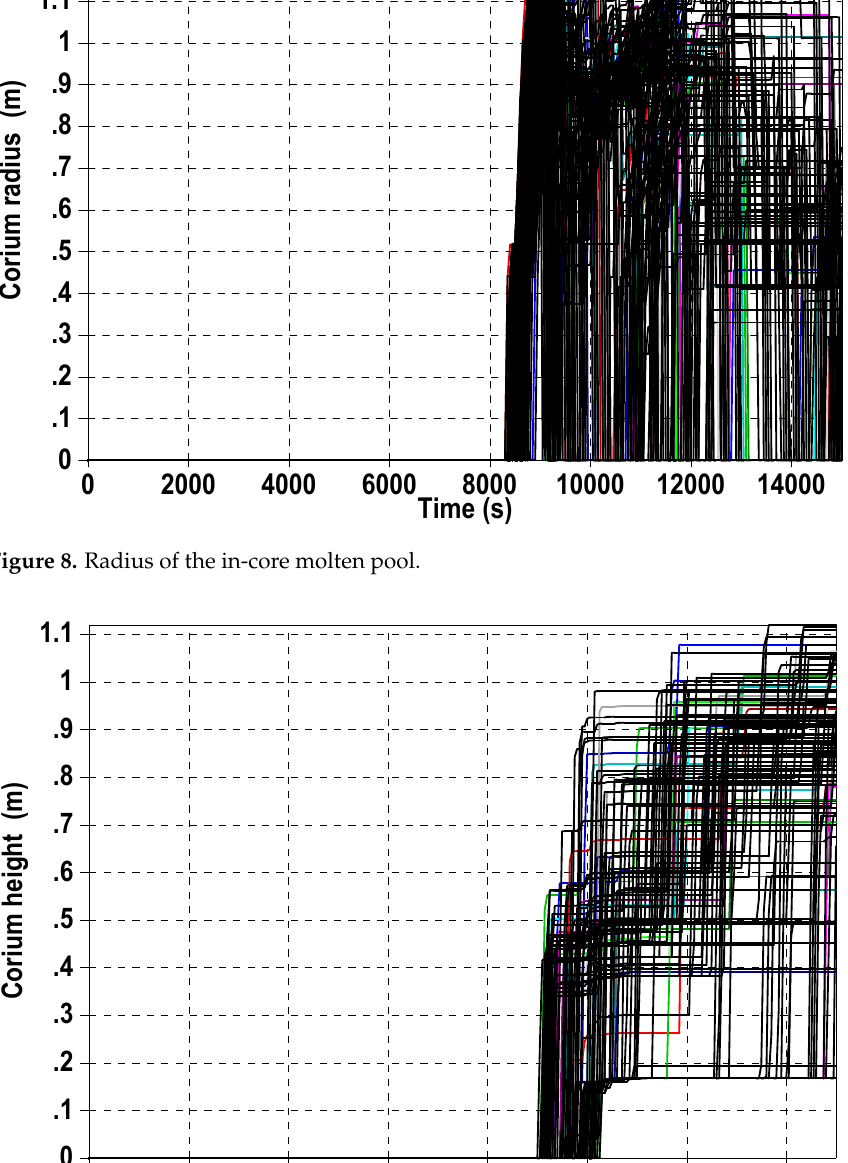
Figure 9. Corium height in the lower head.